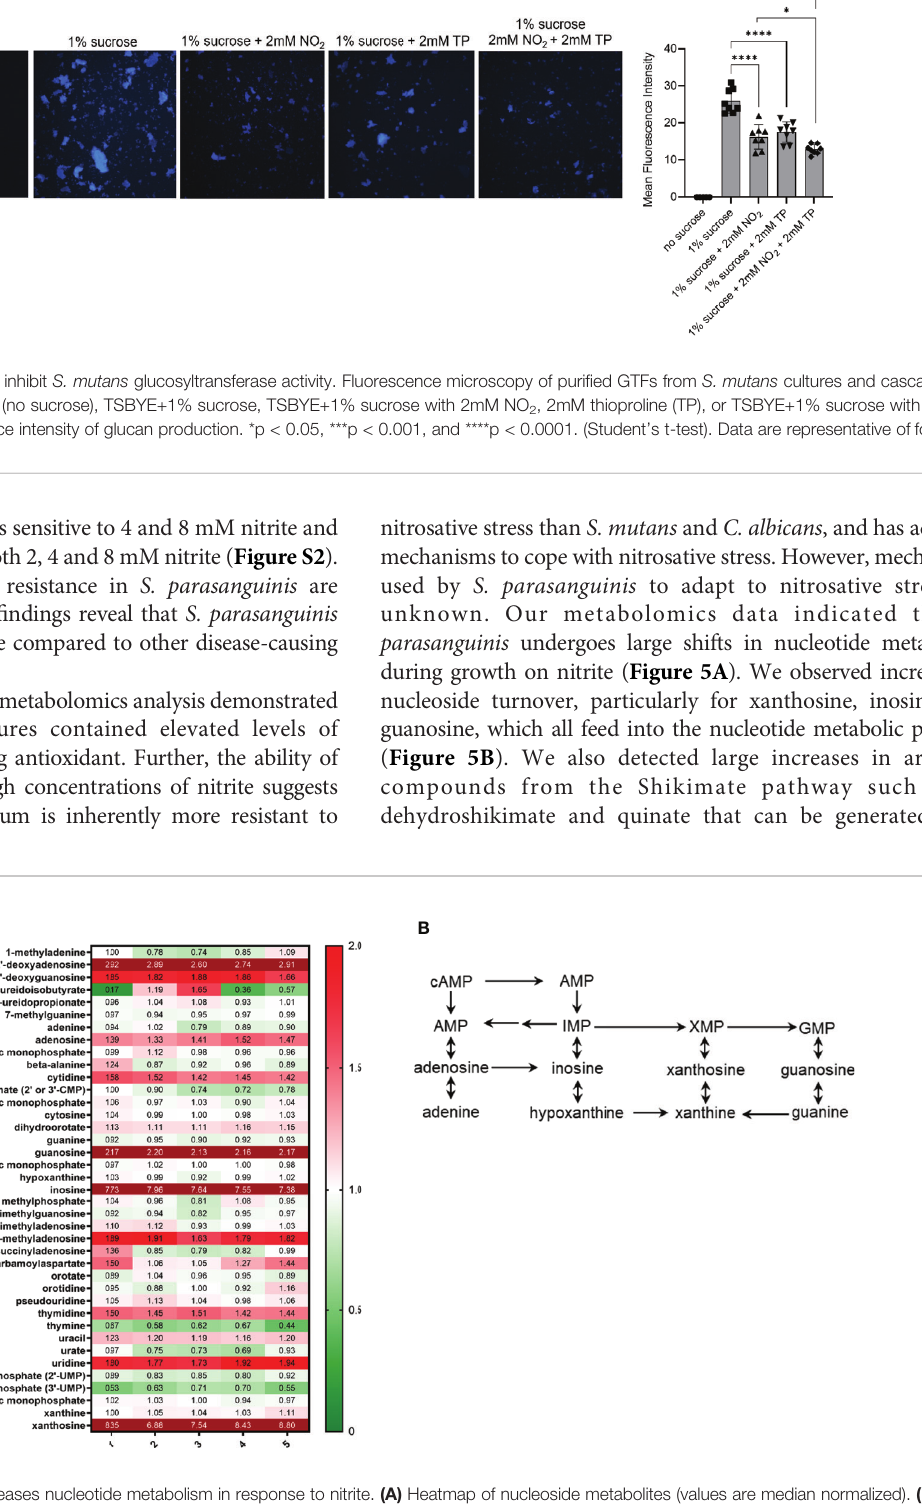
FIGURE 5 | S. parasanguinis increases nucleotide metabolism in response to nitrite. (A) Heatmap of nucleoside metabolites (values are median normalized). (B) Nucleotide metabolic pathway. All cultures were grown for 16 hours in TSBYE and 1% sucrose in 5% CO 2 . Metabolomics data were collected for 5 replicates in each group.